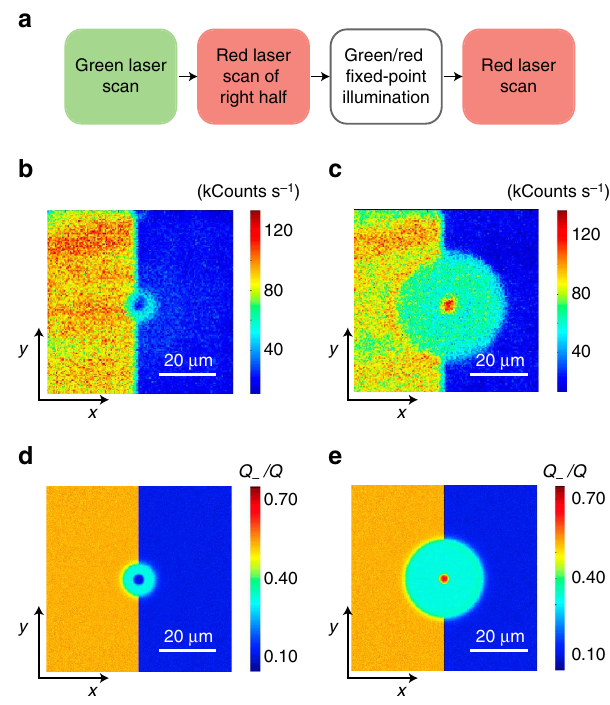
Figure 4 | Pattern formation in the presence of heterogeneous NV (cid:2) content. ( a ) After initializing with a (green) reset scan, we ionize NV (cid:2) on half the sample area via a strong (red) bleach scan; we then focus either the red or green laser to a point approximately at the centre for a fixed time interval, and finally image the result via (a low-intensity red) readout scan. ( b ) Fluorescence image on application of the protocol in a using red, fixed-point excitation during t R ¼ 10s. The red beam power is 1.5mW during the bleach scan, 1.5mW during t R and 100 m W during the readout scan. ( c ) Same as in b but for green fixed-point illumination at 3mW during t G ¼ 10s. In b and c the image size is 150 (cid:5) 150 pixels and the integration time per pixel is 1ms. ( d , e ) Calculated NV (cid:2) map for the conditions in b and c , respectively. Simulation parameters as listed in Supplementary Table 1.